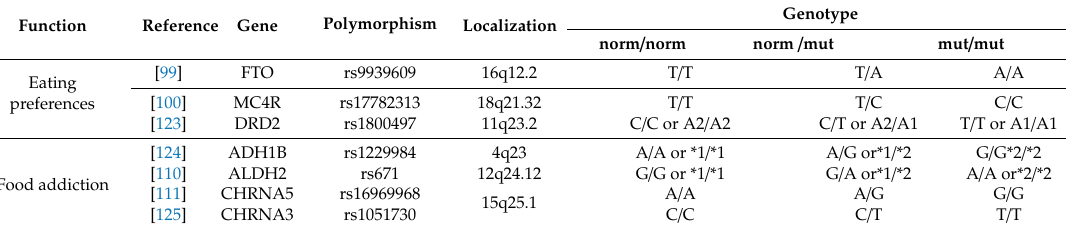
Table 8 presents 34 genes: nine genes responsible for metabolism of carbohydrates and fats, two genes for food intolerance, eight genes for metabolism of vitamins, five genes for taste sensations, three genes for metabolism of xenobiotics, seven genes for eating preferences. In Table 8, polymorphism of some genes is not indicated, e.g., for HLA-DQ genes, since the development of celiac disease depends not on genes polymorphisms, but on their presence. For the ApoE gene, two polymorphisms rs429358 and rs7412 are indicated, which form the three main variants of the gene (ApoE- ε 2, ApoE- ε 3 and ApoE- ε 4), and, so, there are six possible combinations of the ApoE gene: E2 / 2, E2 / 3, E3 / 3, E4 / 2, E4 / 3, E4 / 4, which are presented in Table 8. Two names are presented for the genotype of DRD2, CYP1A2, ADH1B and ALDH2